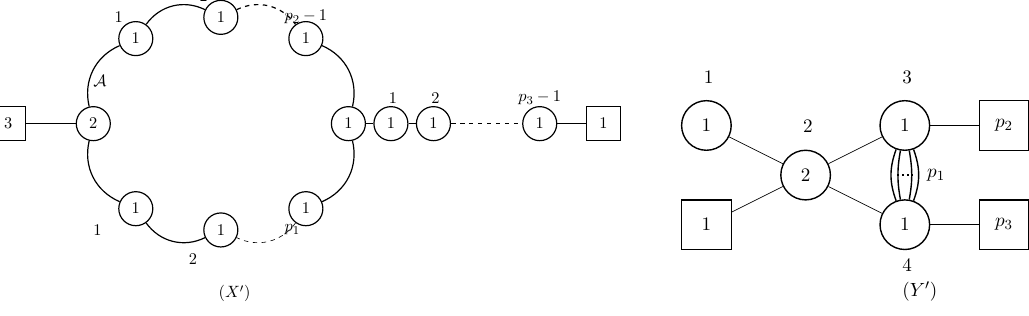
Figure 26 . An infinite family of mirror duals labelled by the positive integers ( p 1 , p 2 , p 3 ) subject to the constraints p 1 , p 1 , and p 1 . The label A denotes a hypermultiplet transforming 1 ≥ 2 ≥ 3 > in a rank-2 antisymmetric representation of U(2) and having charge 1 under U(1)